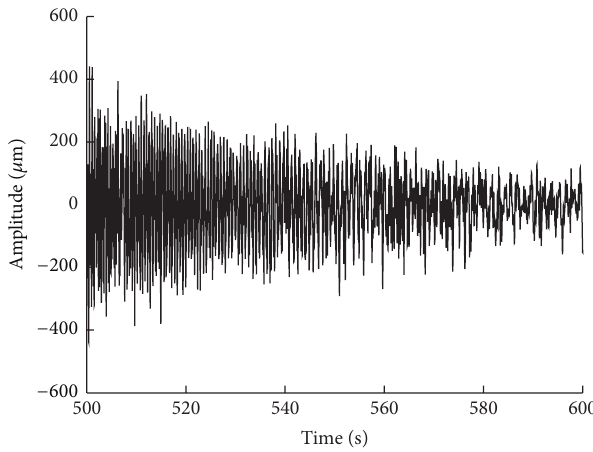
Figure 1: Vibration response of the shaft system.